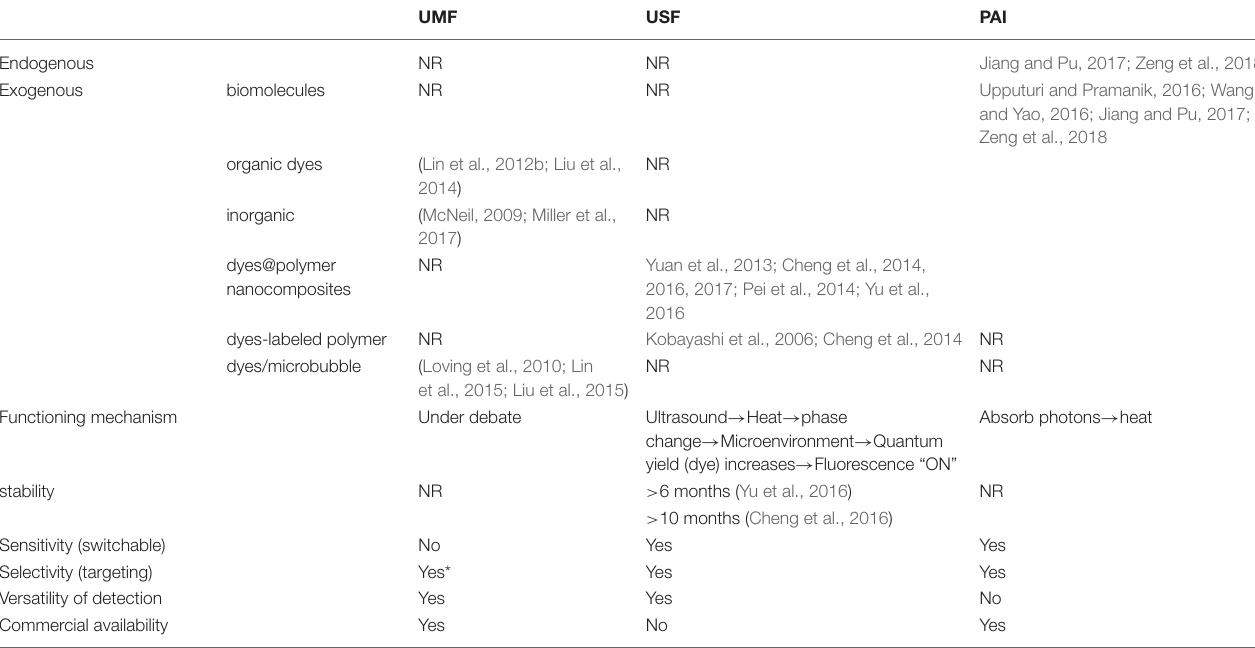
TABLE 1 | Overview of contrast agents for UMF, USF, and